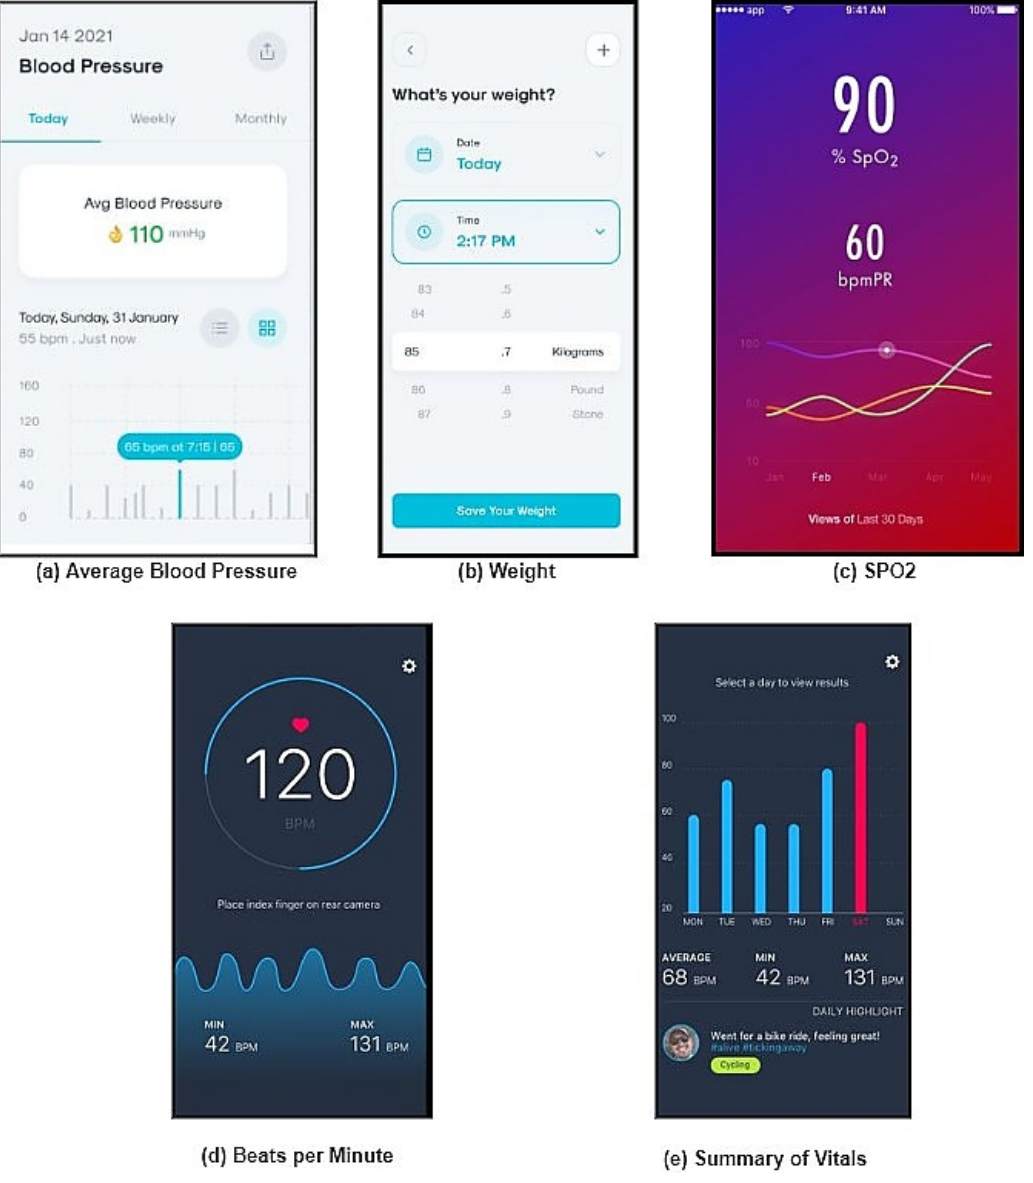
Figure 9. Visualization of real-time data through mobile application.